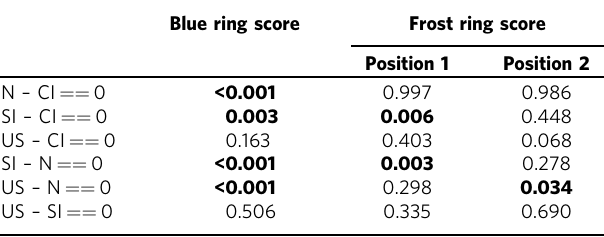
P -values were adjusted for multiple comparisons with the Tukey method. Bold indicates signi fi cance at the 0.05 threshold